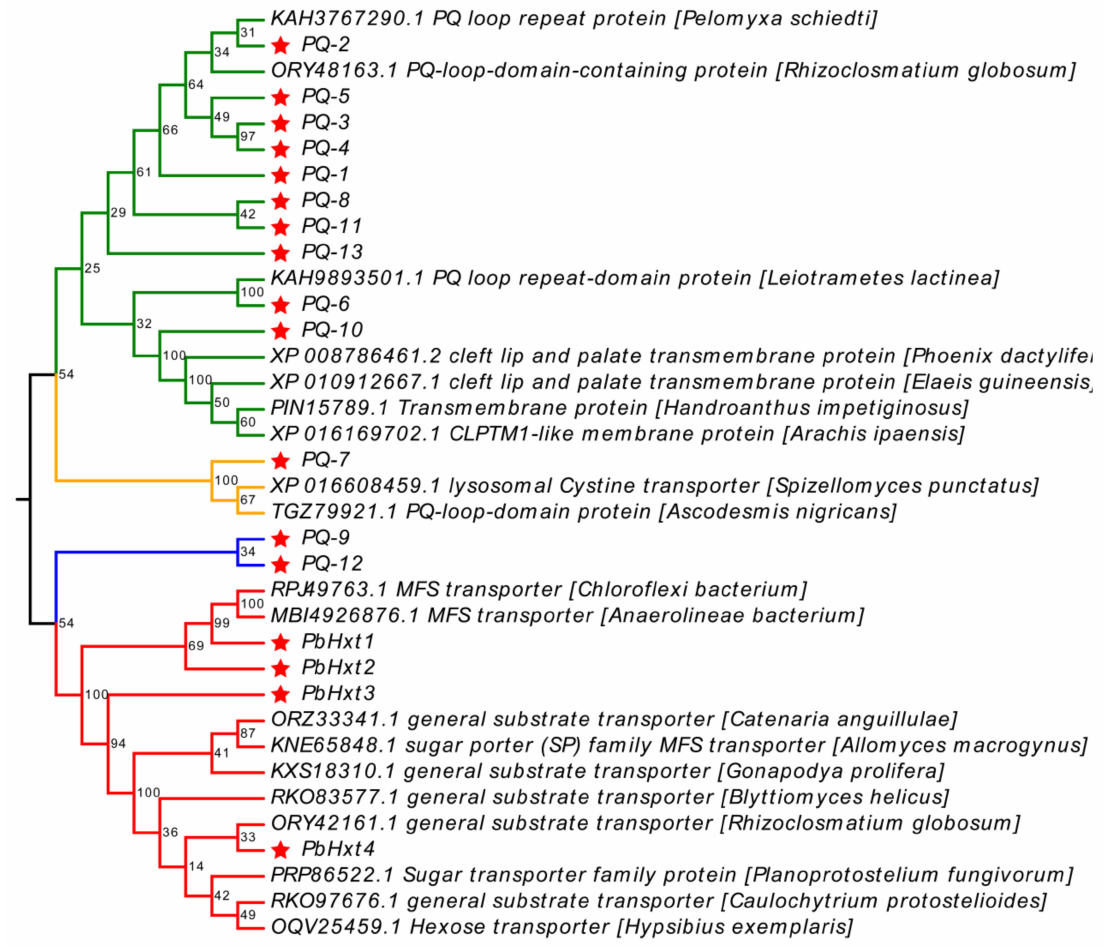
Figure 3. Phylogenetic relationships of Plasmodiophora brassicae sugar transporters. The unrooted phylogenic tree was constructed using 36 amino acid sequences. The phylogenic tree was constructed with MEGA6 using the neighbor-joining method. The red stars represent the putative sugar trans- porters of P. brassicae. Each colored branch represents a different clade. The letters in front of the other sequences represent the GenBank number of the protein. The words in square brackets “[]” show the genus and species